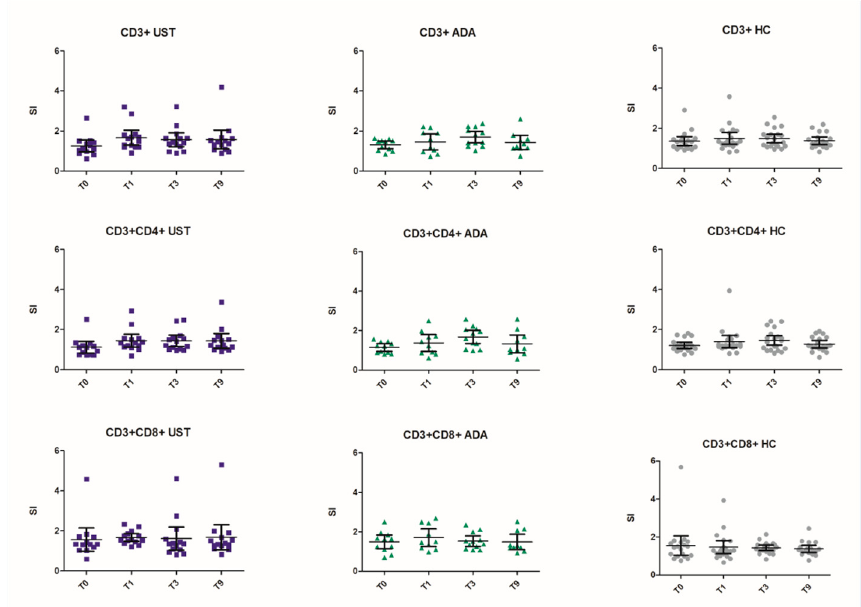
Figure 3. Stimulation indexes for each participant in the three study groups per T-cell subset. T0 = pre-vaccination, T1 = one-month post-vaccination, T3 = three months post-vaccination, T9 = nine months post-vaccination. SI = stimulation index. UST = ustekinumab group (blue square), ADA = adalimumab group (green triangle), HC = healthy controls (grey circle). CD3+ = CD3 + T-cells, CD4+ = CD4 + T-cells (T helper cells), CD8 + = CD8 + T-cells (cytotoxic T-cells). 95% confidence intervals are shown.